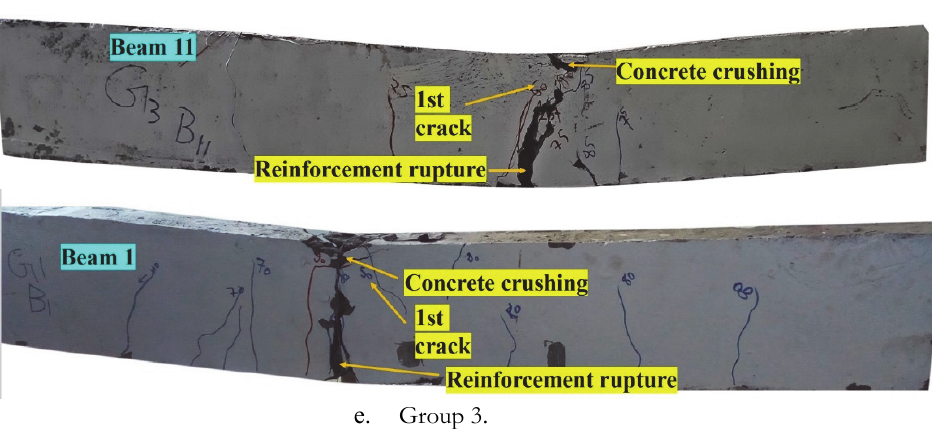
e. Group 3 . Figure 7: Crack propagation and failure modes of tested beams : (a) Control beam, (b) Group 1, (c) Group 2, and (d) Group 3.